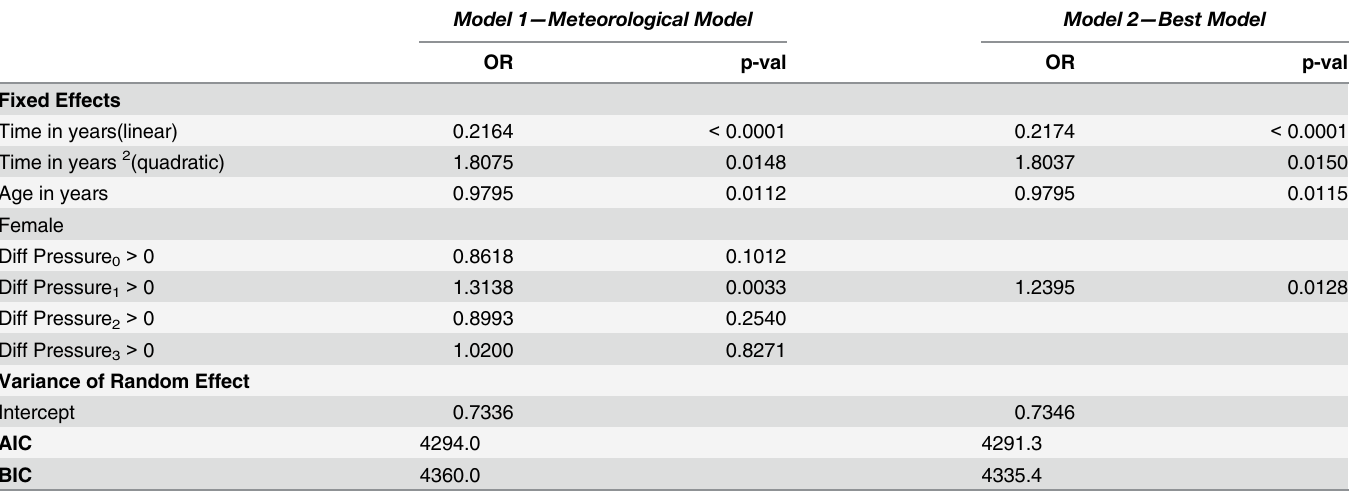
Table 6. Results of the generalized linear mixed models with change in air pressure dichotomized at zero presented with Odds Ratios (OR), p-val- ues (p-val), Akaike Information Criteria (AIC) and Bayesian Information Criteria (BIC).